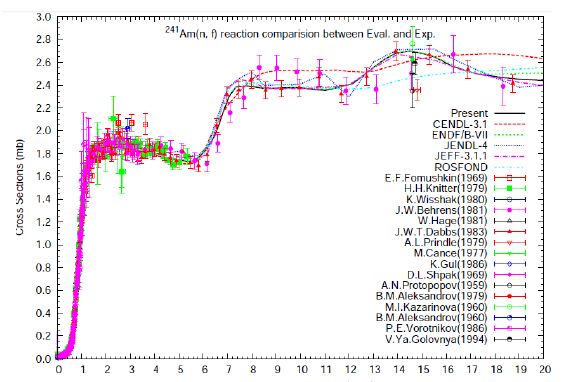
Fig. 18 . The comparison of the updated 241 Am(n,f) in CENDL- 3.2 and the other evaluated and the experimental data.